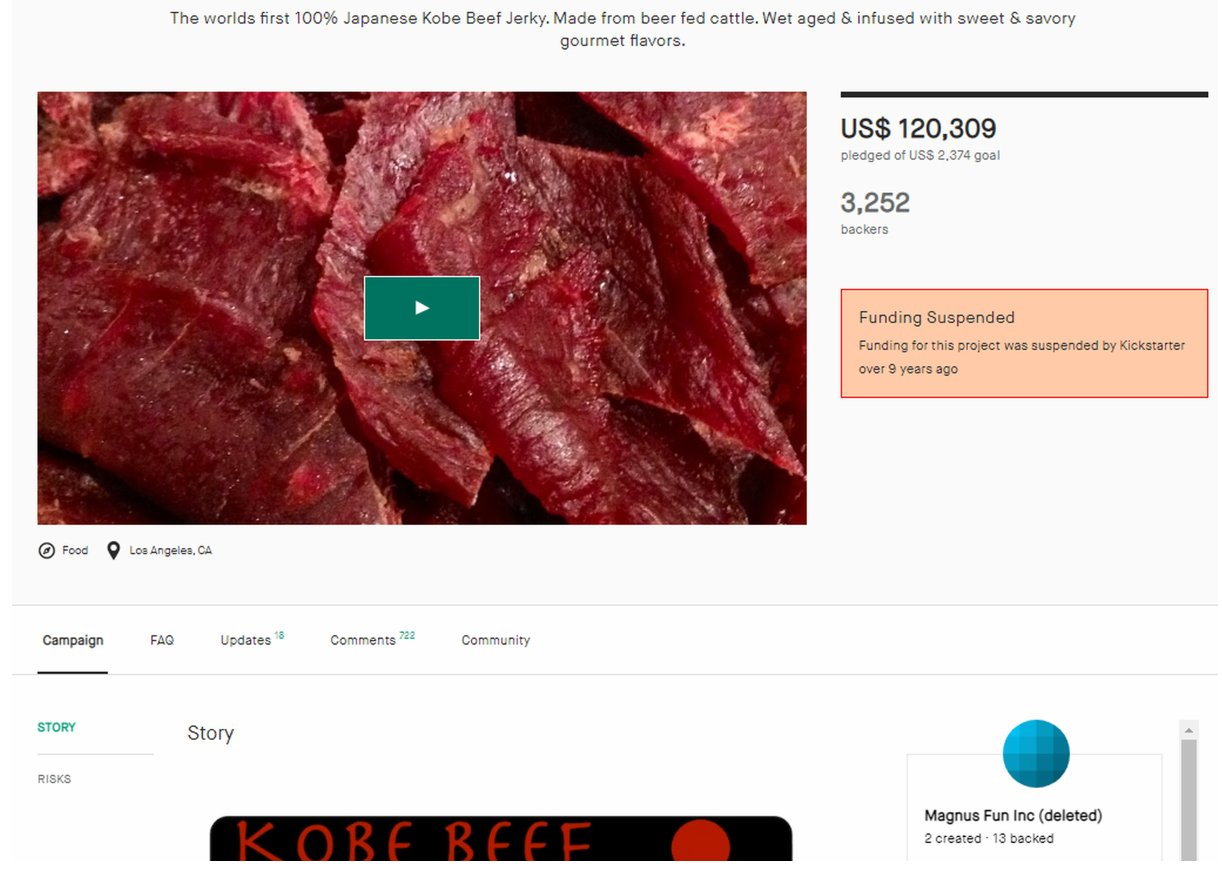
Figure 2. An example screenshot of a crowdfunding